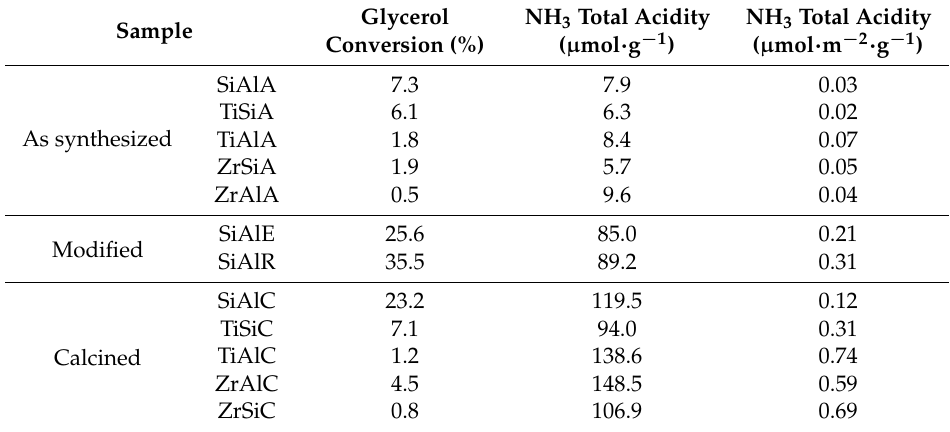
Table 2. Catalytic results in the esterification of glycerol with acetic acid reaction. Reaction conditions were as follows: 75 mg of catalyst, glycerol to acetic acid ratio of 1:3, reaction time of 20 h. Total acidity measurements by ammonia (NH3-TPD) (temperature programmed desorption of